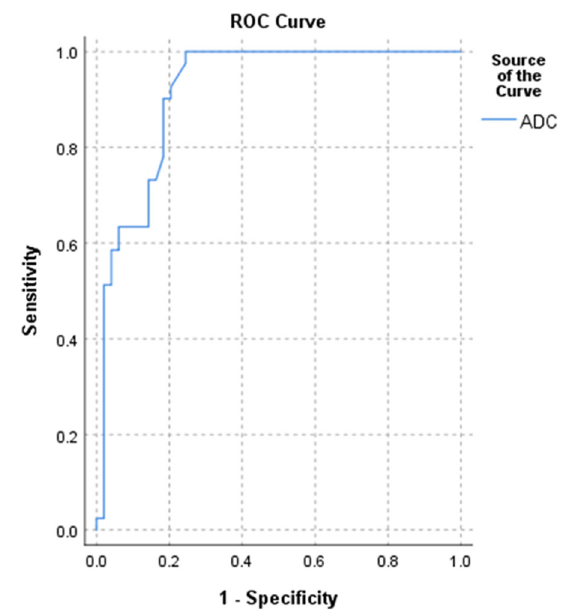
Fig. 2 ROC curve of ADC value for the true-positive rate (sensitivity) was plotted against false-positive rate (specificity) analysis